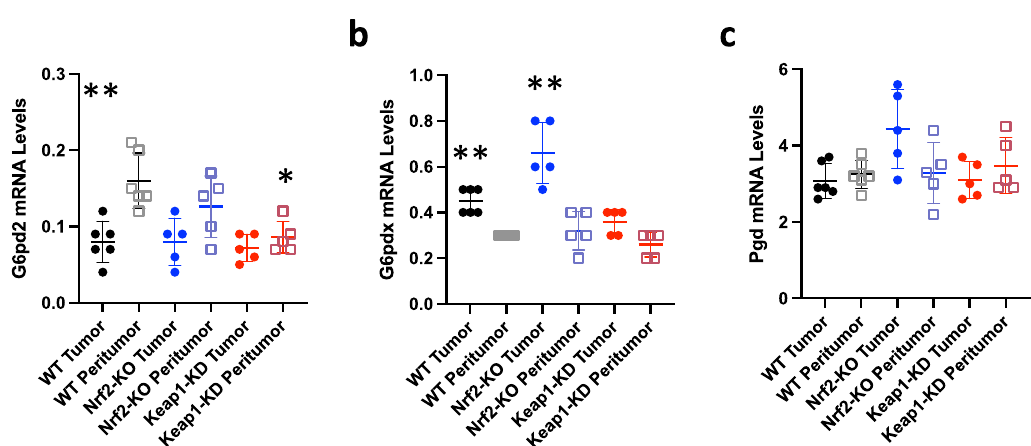
Fig. 8 The expression of G6pdx, G6pd2 and Pgd is not coordinately altered in colorectal adenomas. a – c mRNA levels for G6pd2 ( a ), G6pdx ( b ) and Pgd ( c ) in tumor vs. peri-tumoral tissues in Gstp − / − : Apc Min/ + : Nrf2 + / + : Keap1 + / + (WT) and Gstp − / − : Apc Min/ + : Nrf2 − / − : Keap1 + / + (Nrf2-KO) mice ( n = 5 – 6). Rplp0 was used as the reference gene. * p < 0.05 vs. WT peri-tumor; ** p < 0.05 tumor vs.